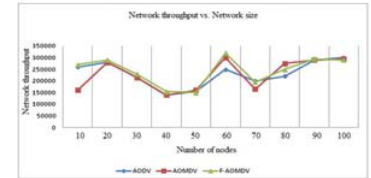
Fig. 6. Performance assessment vs. Network throughput